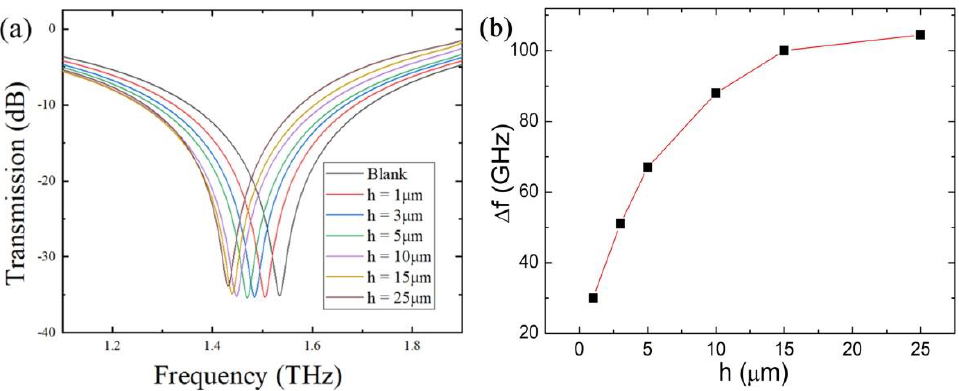
Figure 3. ( a ) Transmission spectra of the sensor covered by analyte with different thicknesses; ( b ) Plot of ∆ f vs. h with the red curve included to guide the eyes.